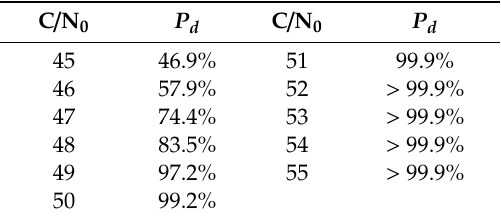
Table 2. Probability of spoofing detection with ∆ a thr = 3.6.